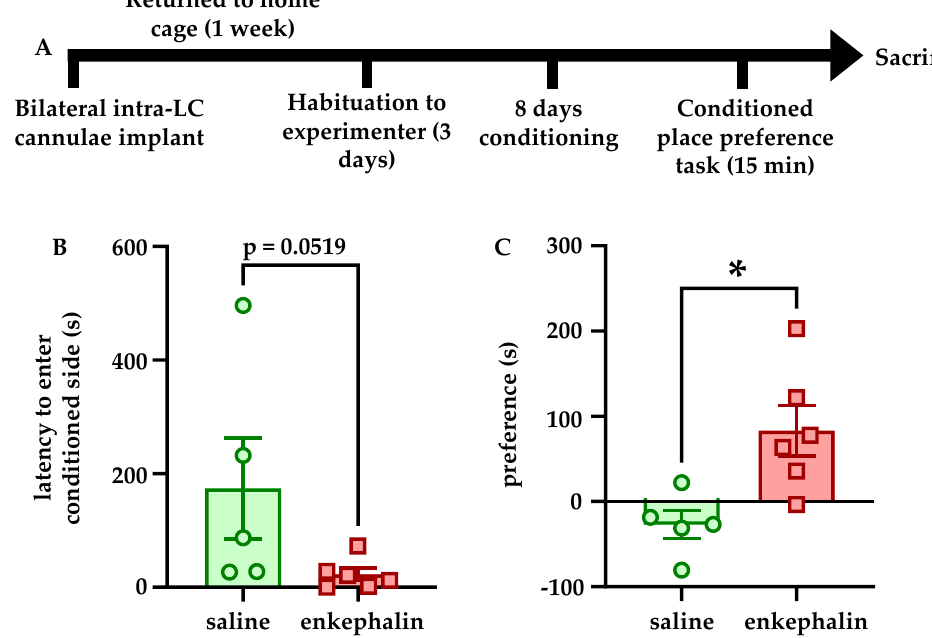
Figure 4. Intra-LC infusions of enkephalin promote conditioned place preference. The experi- mental timeline is shown in ( A ). Rats were habituated to handling by the experimenter for 3 days but were naïve to the behavioral apparatus when conditioning began. Rats that received enkephalin infusions showed a strong trend for entering the conditioned side of the CPP apparatus with shorter latency than the rats that received saline infusions in the conditioned side ( p = 0.0519, ( B )). Rats that received enkephalin infusions in the conditioned side of the CPP apparatus showed a significantly greater preference for that chamber than rats that received saline infusions in the conditioned side ( C ). * p <